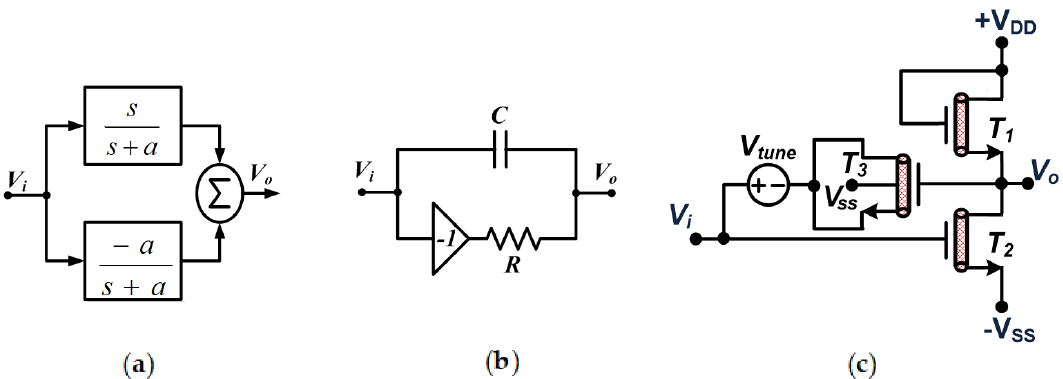
Figure 7. First order APF: ( a ) Basic scheme; ( b ) Equivalent circuit; ( c ) CNFET based implementation.